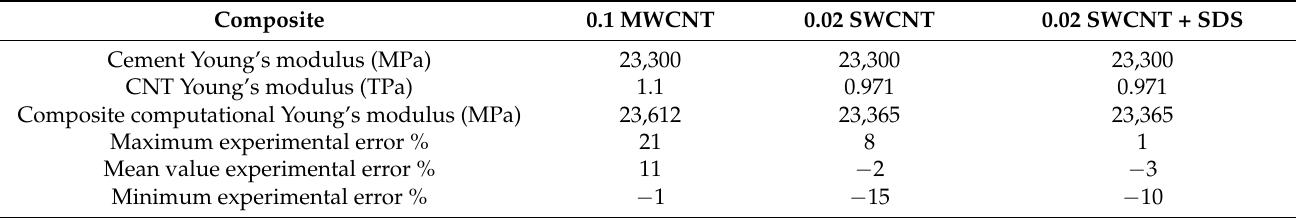
Table 8. Computational results of calculated CNT and composite Young’s modulus values after taking 23,300 MPa as the cement Young’s modulus.